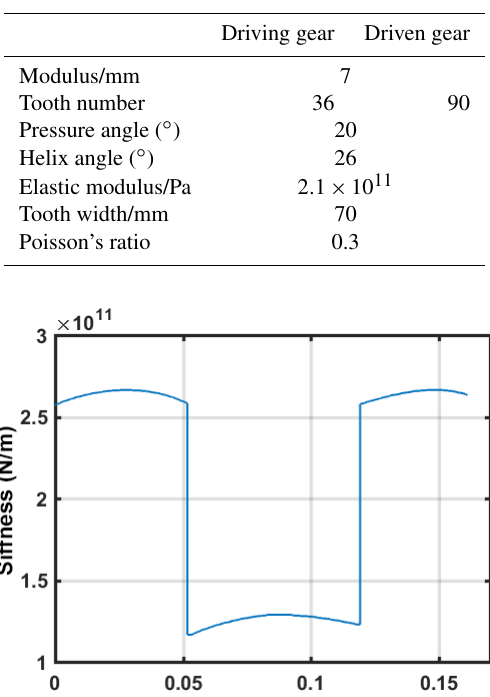
Table 1. A certain type of high-speed train helical gear basic pa- rameters.